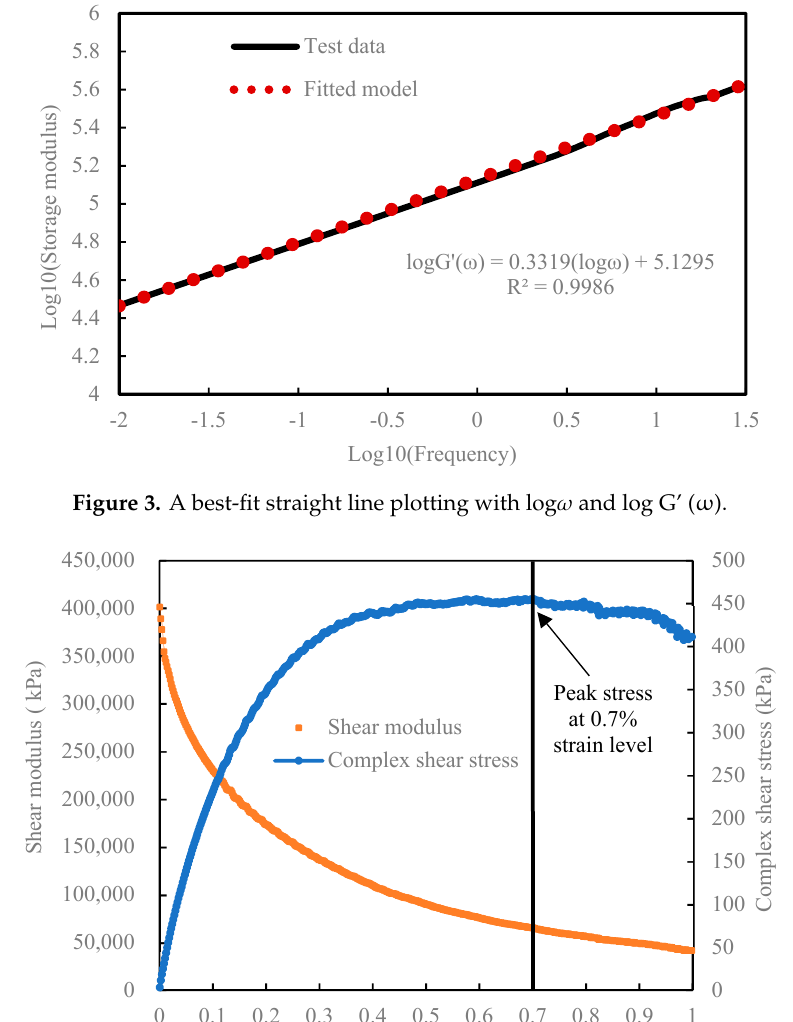
Figure 4. Complex shear stress and shear modulus from amplitude sweep test.